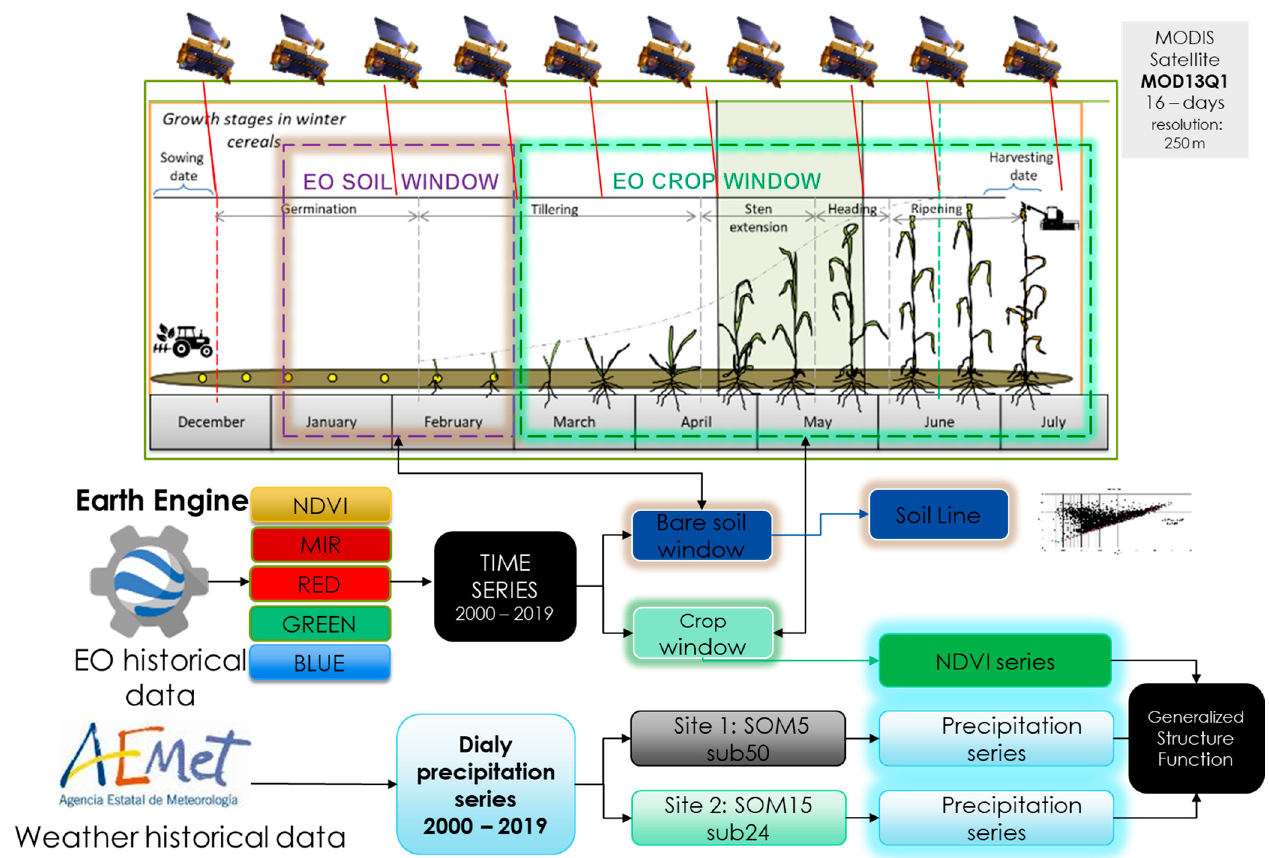
Figure 2. Workflow of the sampling method and information extraction from Earth observations and soils map.